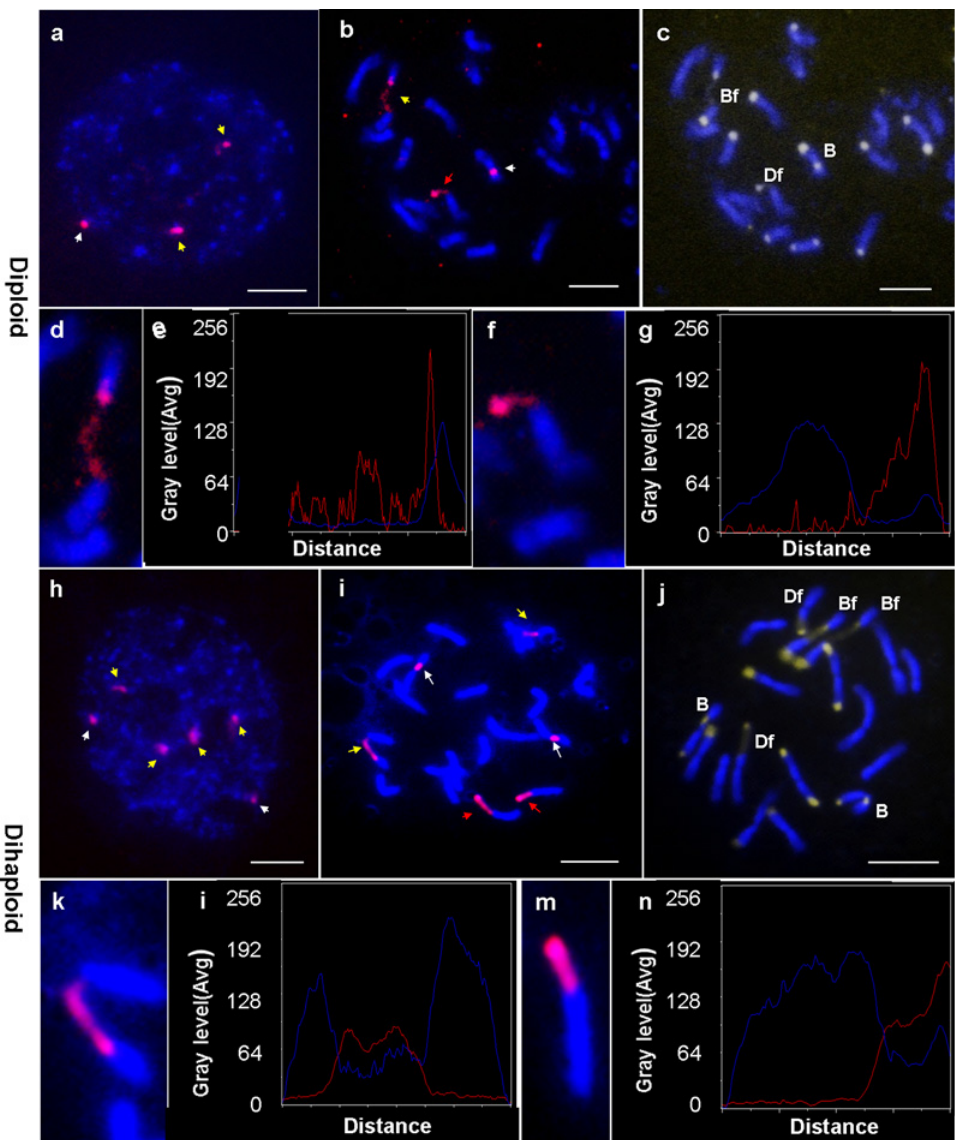
Fig 3. Localization of 45S rDNA by FISH in diploid (a-g) and dihaploid (d-n). a and h, red hybridization signals of 45S rDNA on interphase nucleus stained by DAPI; b and i, red Cy3 as hybridization signals of 45S rDNA on metaphase chromosomes stained by DAPI; c and j, DAPI and CMA staining chromosomes (B, Bf, D and Df indicate the type of each chromosome); d, f, k and m, enlarged images of chromosome with fragile site; e, g, i and n, linescan curve analysis of fluorescence signals for the chromosomes with 45S signals. The horizontal axis is the length of one chromosome, and the vertical axis is the gray level which measures the intensity of the fluorescent dye and signals. The red line represents the hybridization site and signal intensity, and the blue line shows chromosomes stained by DAPI. The yellow arrows indicate proximal decondensed 45S rDNA loci and the red arrows indicate the subterminal decondensed 45S rDNA loci, while white arrows indicate condensed 45S rDNA loci. Bar scales = 5 μ m.